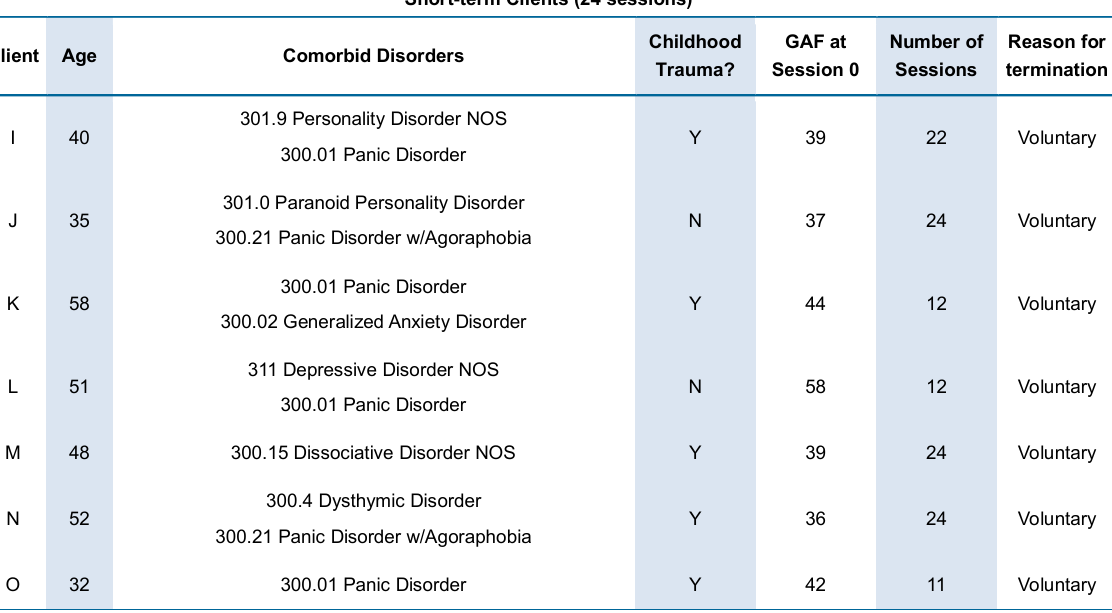
Table 3 Characteristics of sample undertaking short term